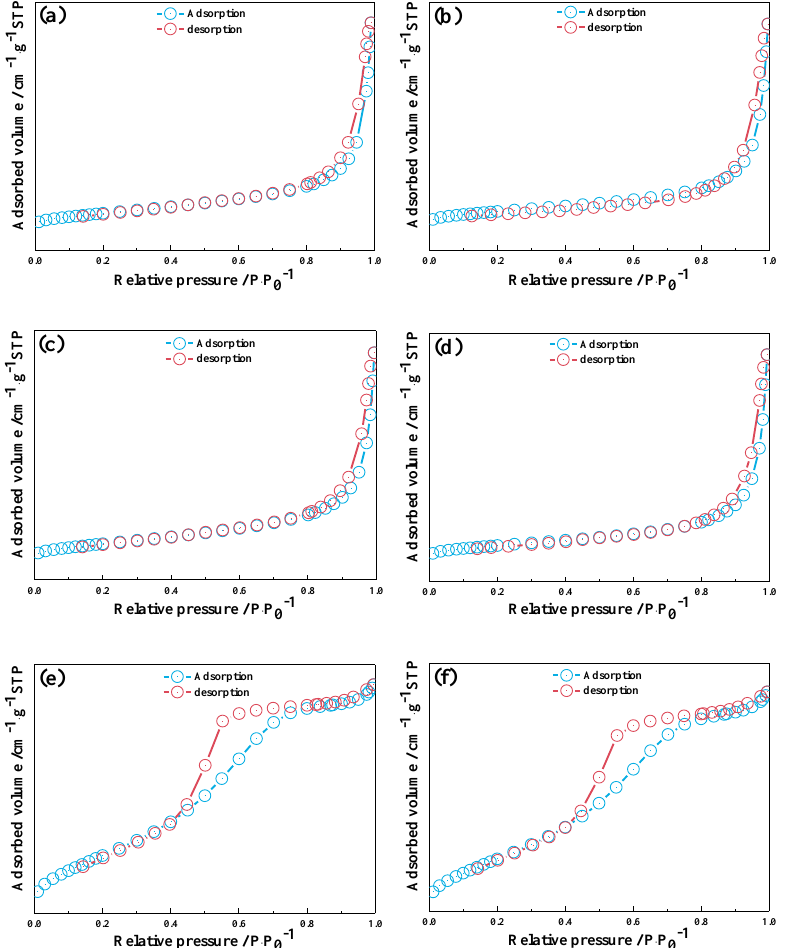
N 2 -adsorption-desorption isotherms of the catalysts SN, SS, CN and CS were classified as V-shaped isotherms with an H3 hysteresis loop. The absorbed volume was really small when the pressure was low. Only when the pressure was approaching the saturated vapor pressure did the absorbed volume increase rapidly due to capillary condensation. The absorption characteristic was often observed by the weak solid-gas interaction in mesopores on the surface of catalysts. It could be concluded from the type of isotherm and hysteresis loop that disorderly wedge-shaped mesopores were formed by particles accumulated loosely on the surface of the catalysts [44].